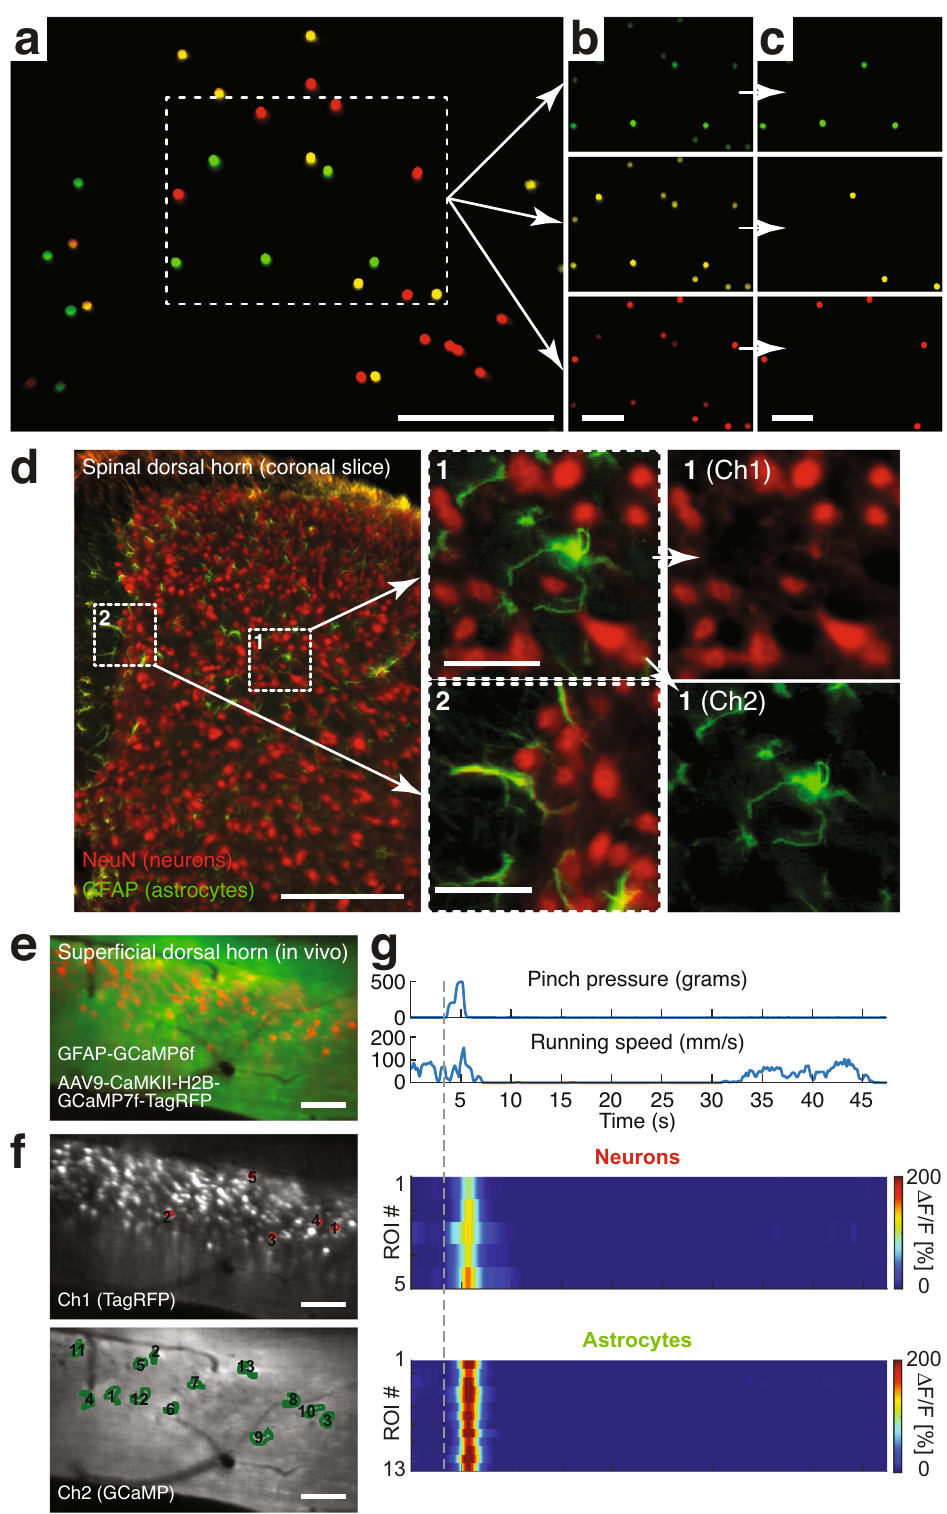
when imaging through a 0.7 mm × 0.7 mm × 0.7 mm (W × D × H) (Fig. 3b, e, h) or custom 0.7 mm × 0.7 mm × 1.7 mm microprism (Fig. 3c, f, i). The bead ’ s lateral full width at half maximum